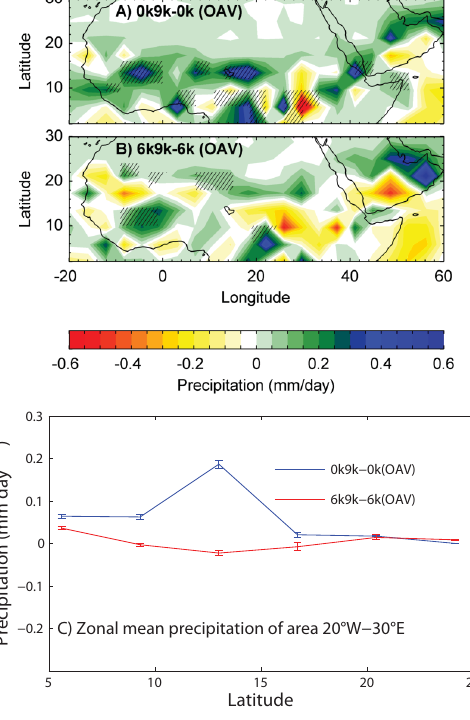
Figure 6. Influence of vegetation initial conditions (9k North African vegetation cover versus bare soil) on pre-industrial and mid-Holocene North African climate simulations. Shown are differ- ences in summer precipitation for (a) 0k9k–0k(OAV) and (b) 6k9k– 6k(OAV). Hatched areas display significant precipitation differ- ences (95% confidence level) according to both a (non-parametric) Wilcoxon–Mann–Whitney test and a Student’s t test. The lower panel (c) shows the corresponding zonal averages over North Africa (20 ◦ W–30 ◦ E) along with standard